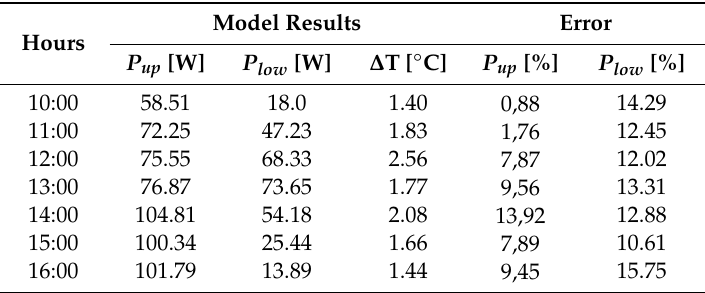
Table 2. Results obtained by the developed PowerCollector ™ model for the cooling experiment with the new orientation value. Model Hours